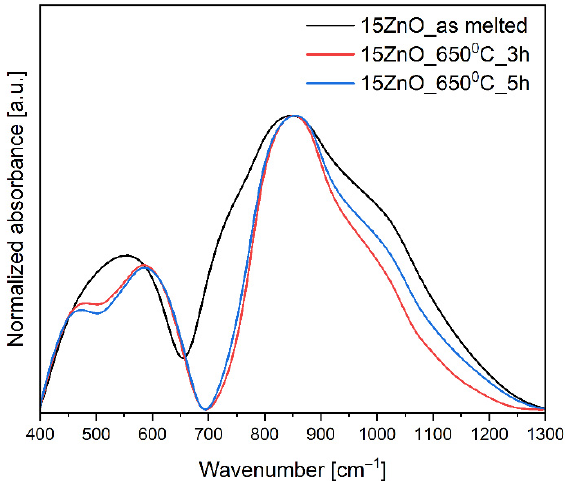
Figure 2. MIR spectra of the glass and glass-ceramics co-doped with Ni 2+ and Er 3+ .